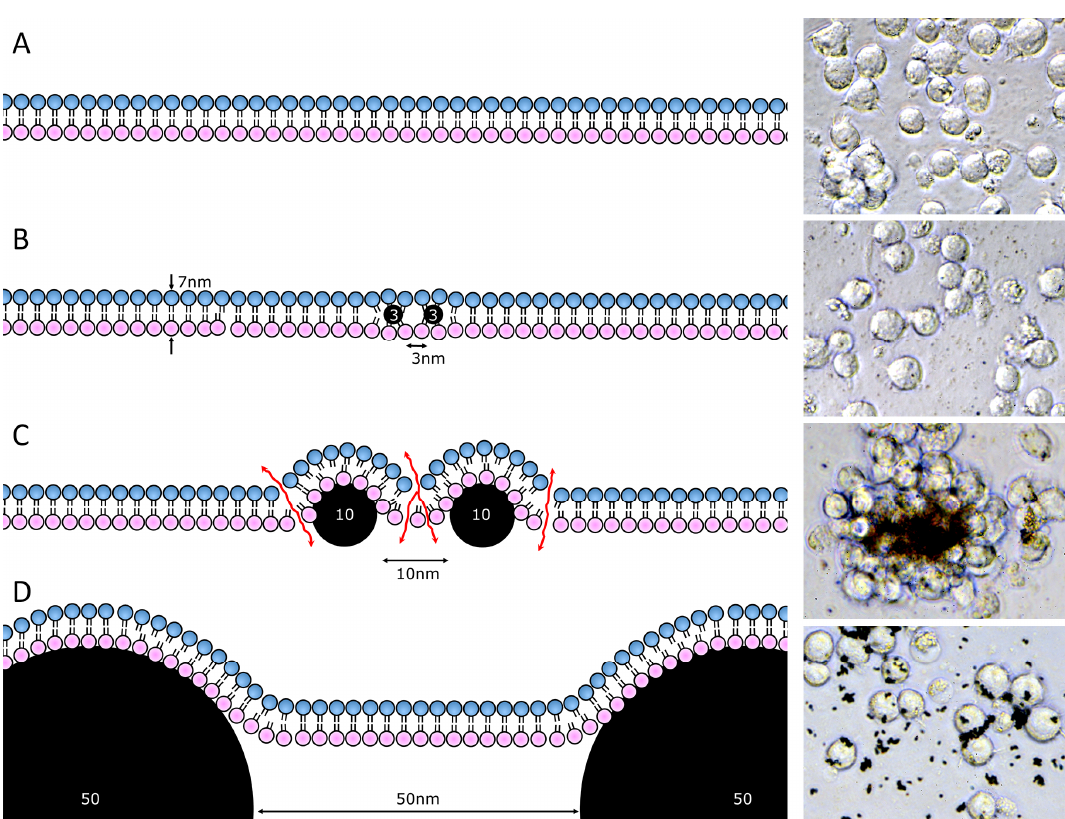
Figure 1. Interaction of lipophilic n / µ P with plasma membranes. Schemes demonstrate curvature of lipid bilayer upon interaction with n / µ P located on the distance equal to their diameter. Photo inserts demonstrated morphology of Jurkat cells incubated at 2 × 10 6 per ml overnight with the corresponding n / µ P (1 mg / ml of cell suspension). ( A ) intact plasma membrane and untreated cells. ( B ) interaction of plasma membrane and n / µ P with diameter smaller than the thickness of PM, e.g., 3 nm nP; cells were treated with fullerenes C60 (van der Waals diameter = 1,1nm). ( C ) interaction with NP whose diameter is between 1 × and 5 × the thickness of PM, e.g., 10 nm nP, cells were treated with 10 nm nano-diamonds. ( D ) interaction with n / µ P with diameters more than fivefold the thickness of PM, e.g., 50 nm nP; cells were treated with 200 nm